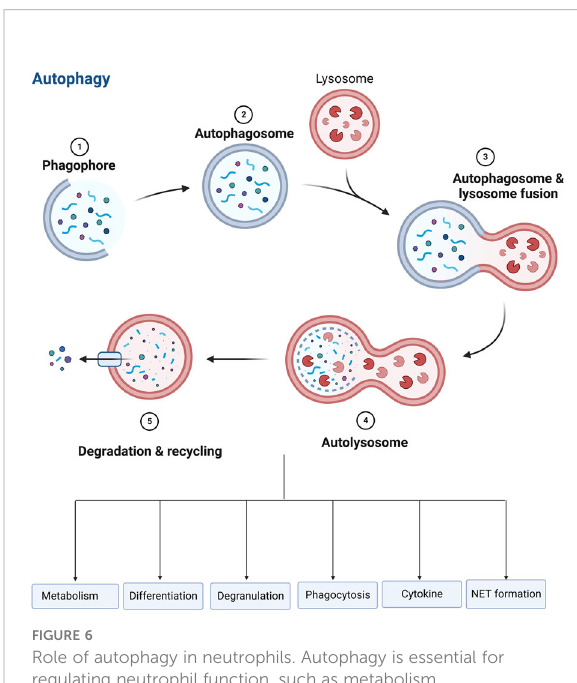
FIGURE 6 Role of autophagy in neutrophils. Autophagy is essential for regulating neutrophil function, such as metabolism, differentiation, degranulation, phagocytosis, cytokine production, and NET